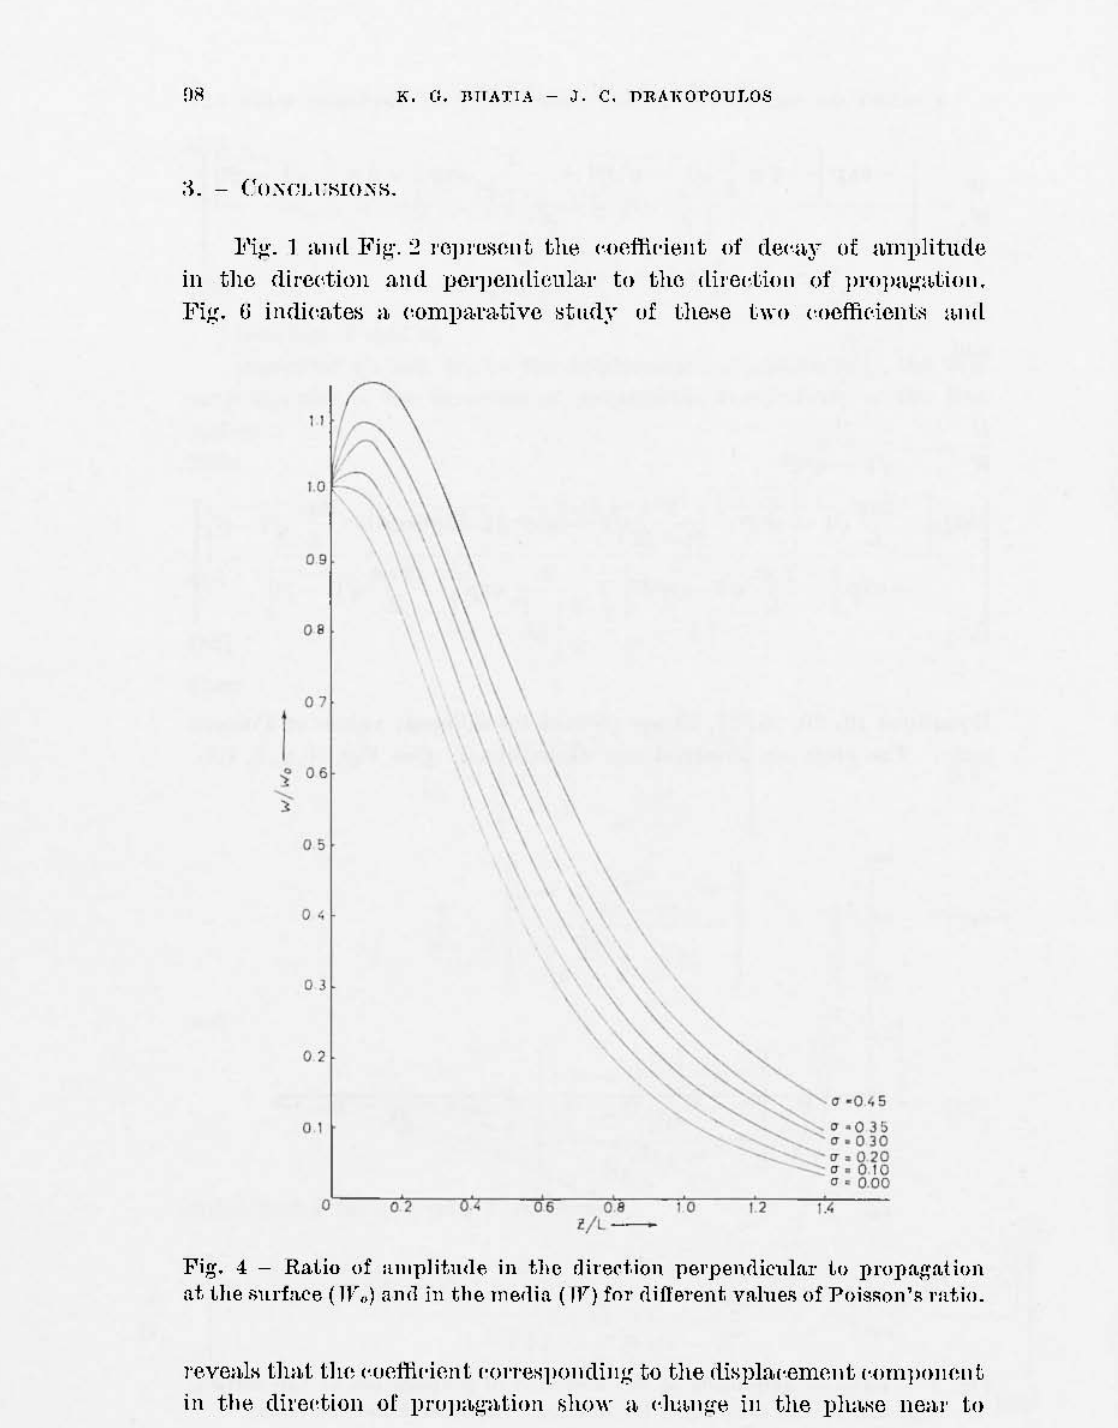
Fig. li indieatcs a eompa,n.tivc ~tlldy of t.hc.~c t.wo ('ocffi('icllt.~ lt,Il(L